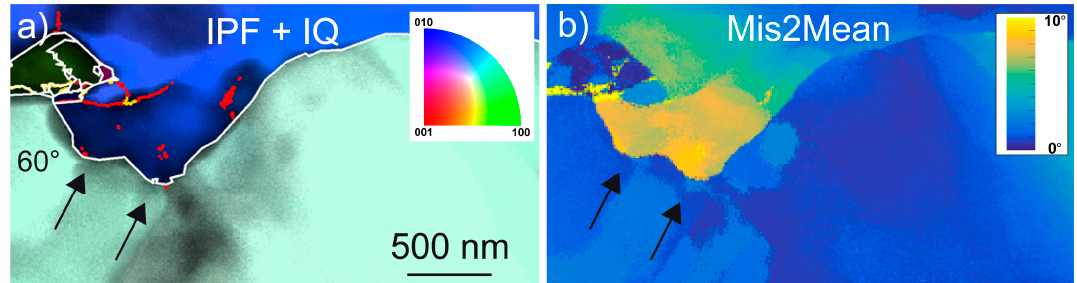
Figure 8. For70B GB bulging. ( a ) IPF corresponding to the direction perpendicular to the plane of view superimposed with the IQ (Equation (1)); color code inserted ( Pnma ). The GB arrowed in black (and highlighted by a white line) has a misorientation of 60°. The SGB in formation is highlighted by a red line. ( b ) Mis2Mean map corresponding to ( a ), up to 10 °.